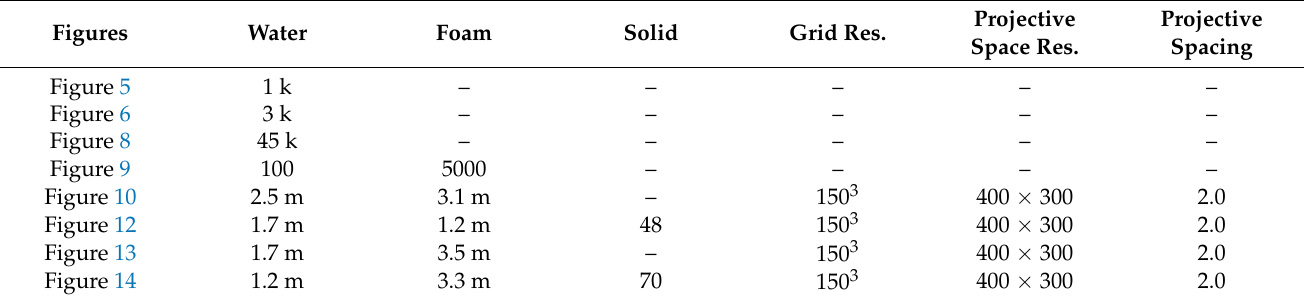
Table 2. Size of our example scene (Water: water particles, Foam: foam particles, Solid: triangles of the solid, Grid res.: grid